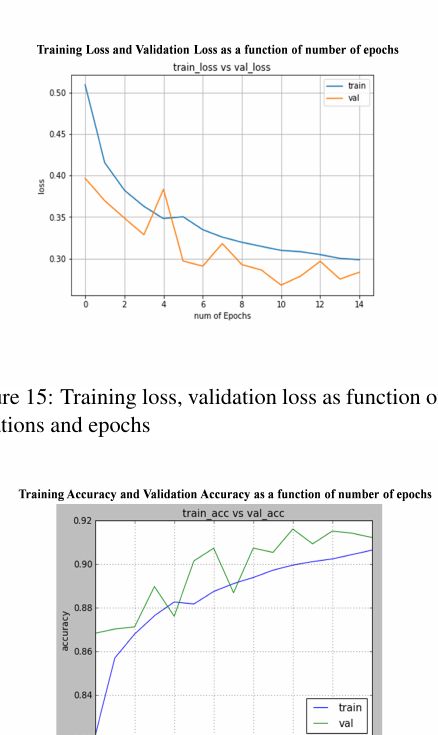
Figure 14: Results and analysis on drone high resolution imagery